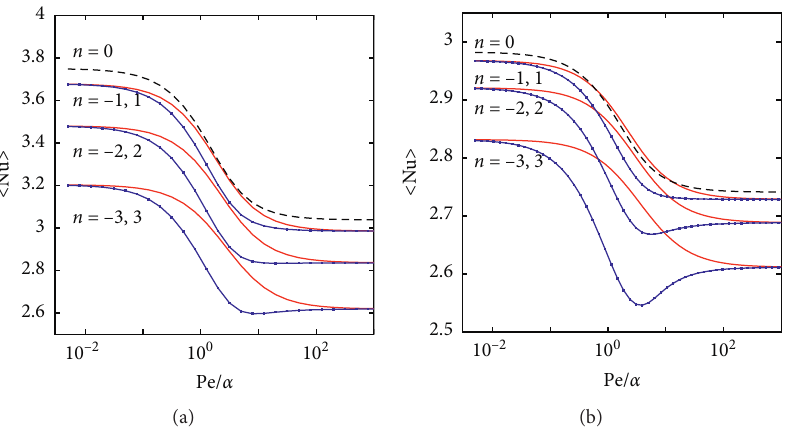
Figure 12: 〈 Nu 〉 versus Pe / α for q ( ζ ) � ( ne − n ζ ) / ( 1 − e − n ) with viscous dissipation Br � 0 . 1. n � 0 (black broken line) corresponds to a w constant function q w ( ζ ) � 1. Blue lines with dots correspond to axially increasing wall heat flux, n < 0. Red continuous lines correspond to axially decreasing wall heat flux, n > 0. (a) Kn � 0; (b) Kn � 0 .